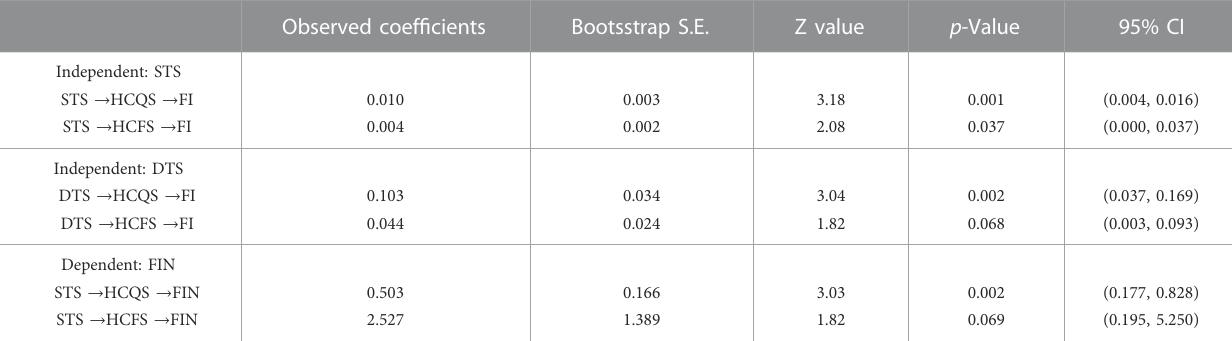
TABLE 10 Indirect effects of mediated